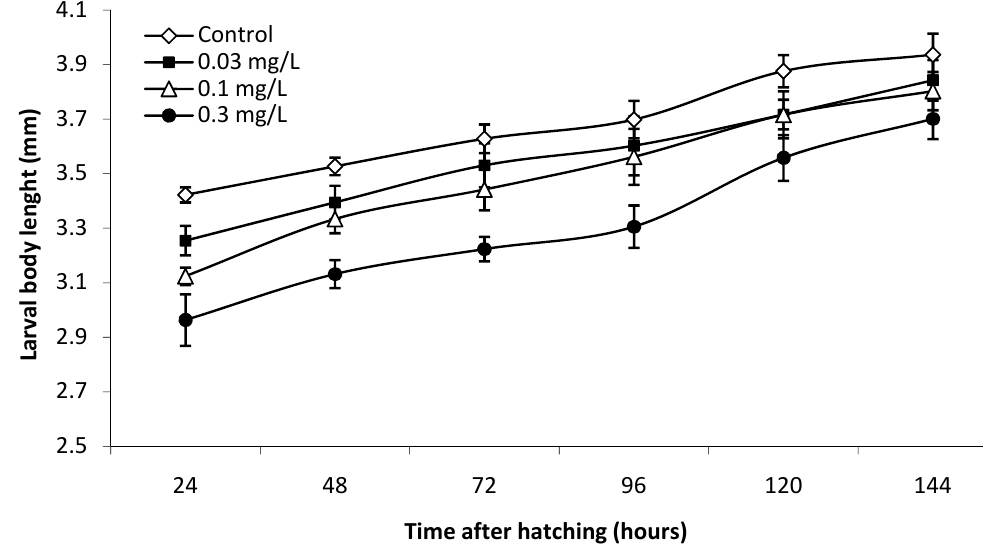
Figure 3. Effects of pre-exposure to a Microcystis aeruginosa natural bloom extract on the larval development of the zebrafish ( Danio rerio ). Values are mean ± S.E. of 30 animals per treatment.